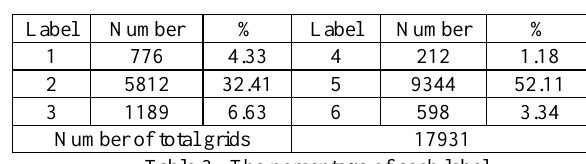
Table 2. Six labels and classification criteria